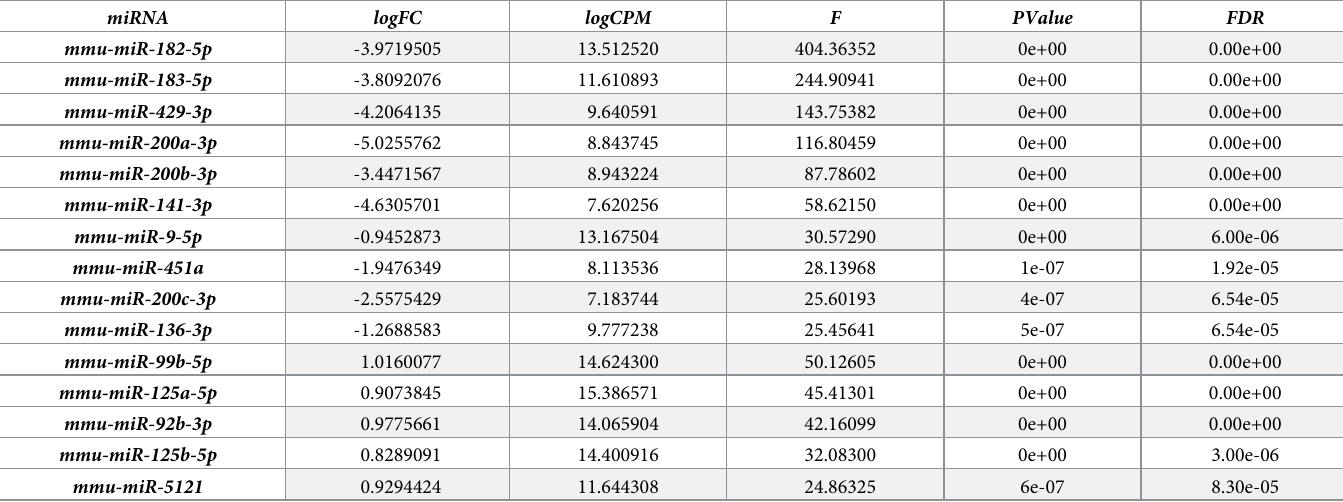
Table 5. Differential expression results for the miRNAs profiles in the comparative TLR4 vs . TLR4-KO mice. miRNA